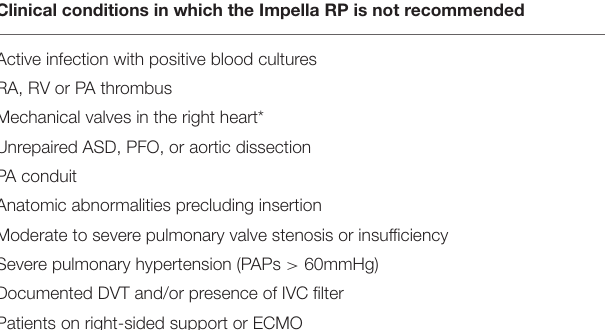
TABLE 4 | Impella RP heart pump patient selection recommendations. Clinical conditions in which the Impella RP is not recommended